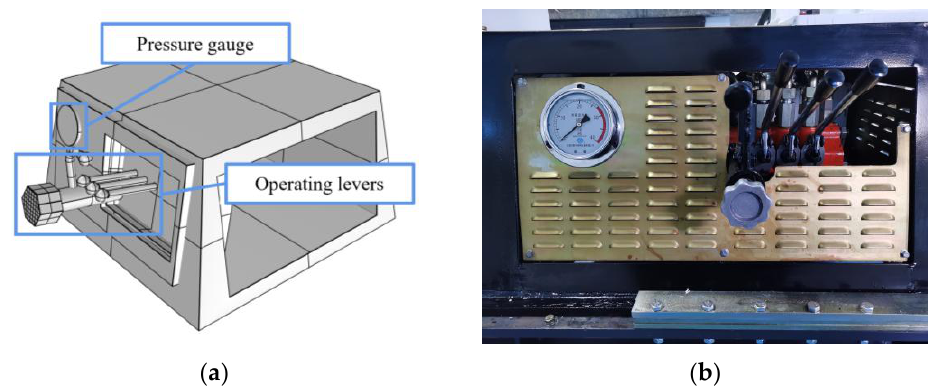
Figure 5. Model and physical drawing of the lifting cylinder. ( a ) Model drawing; ( b ) Physical drawing.